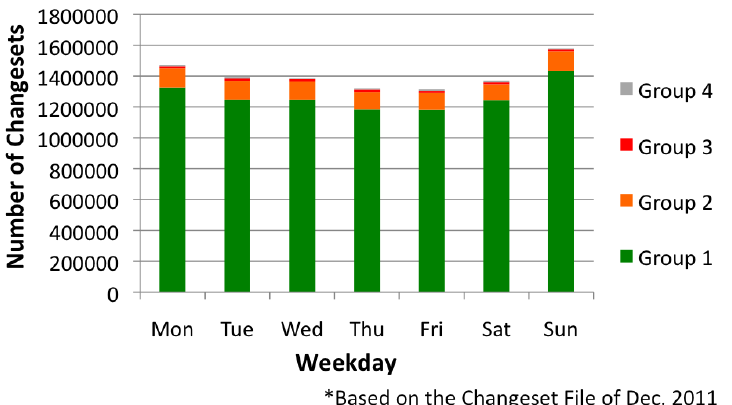
Figure 5. Changesets per weekday*.